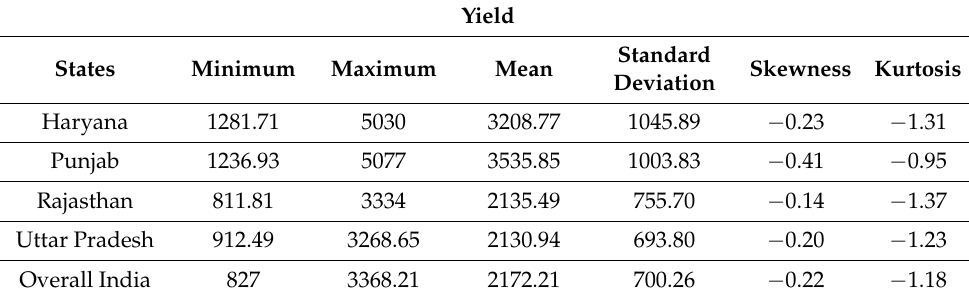
Table 9. Summary statistics of yield of wheat (kg/hectare).